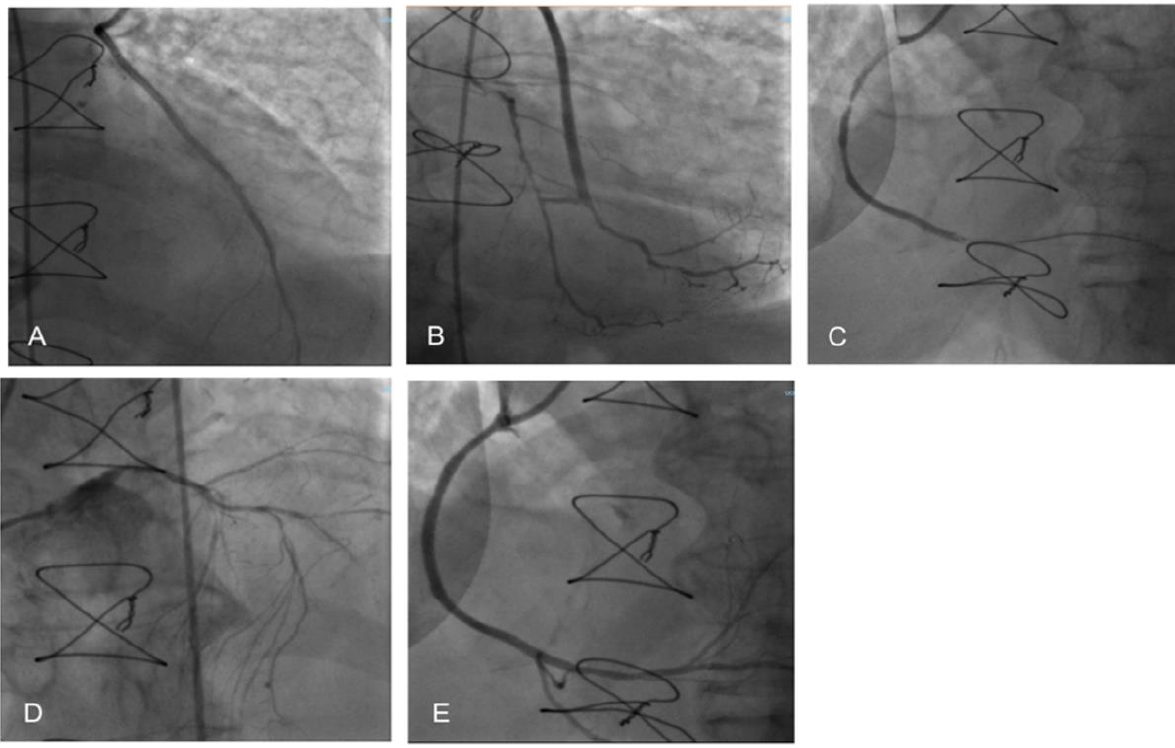
Figure 1. Percutaneous coronary intervention. ( A ) Internal mammary artery on anterior descending artery; ( B ) Y venous graft on an obtuse marginal branch and posterior descending artery; ( C ) Right coronary artery proximal and distal occlusion; ( D ) Left main coronary artery; ( E ) Right coronary artery after percutaneous angioplasty and drug-eluting stent implantation.